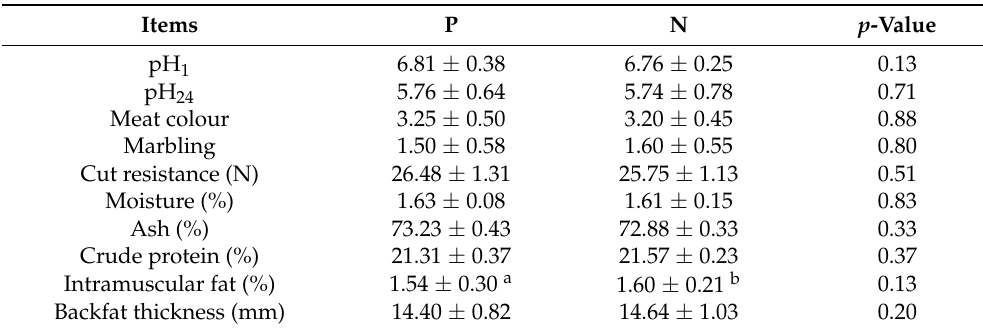
Table 6. Comparison of meat quality and backfat thickness between antibody-positive pigs and antibody-negative